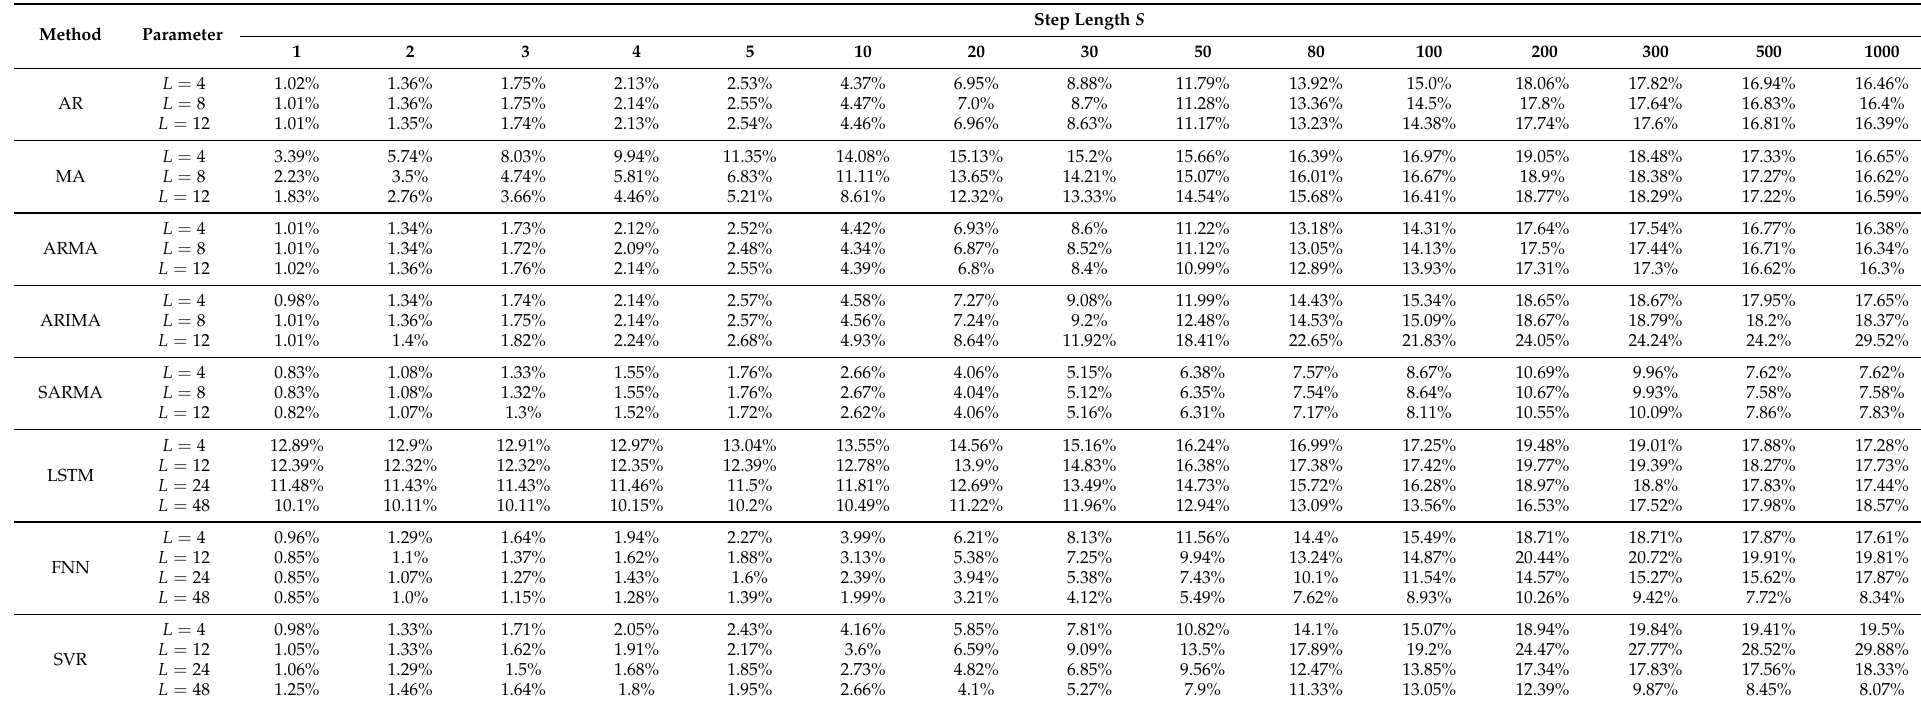
Table 1. MAPE of various methods on the electricity loads dataset under different step lengths and parameter